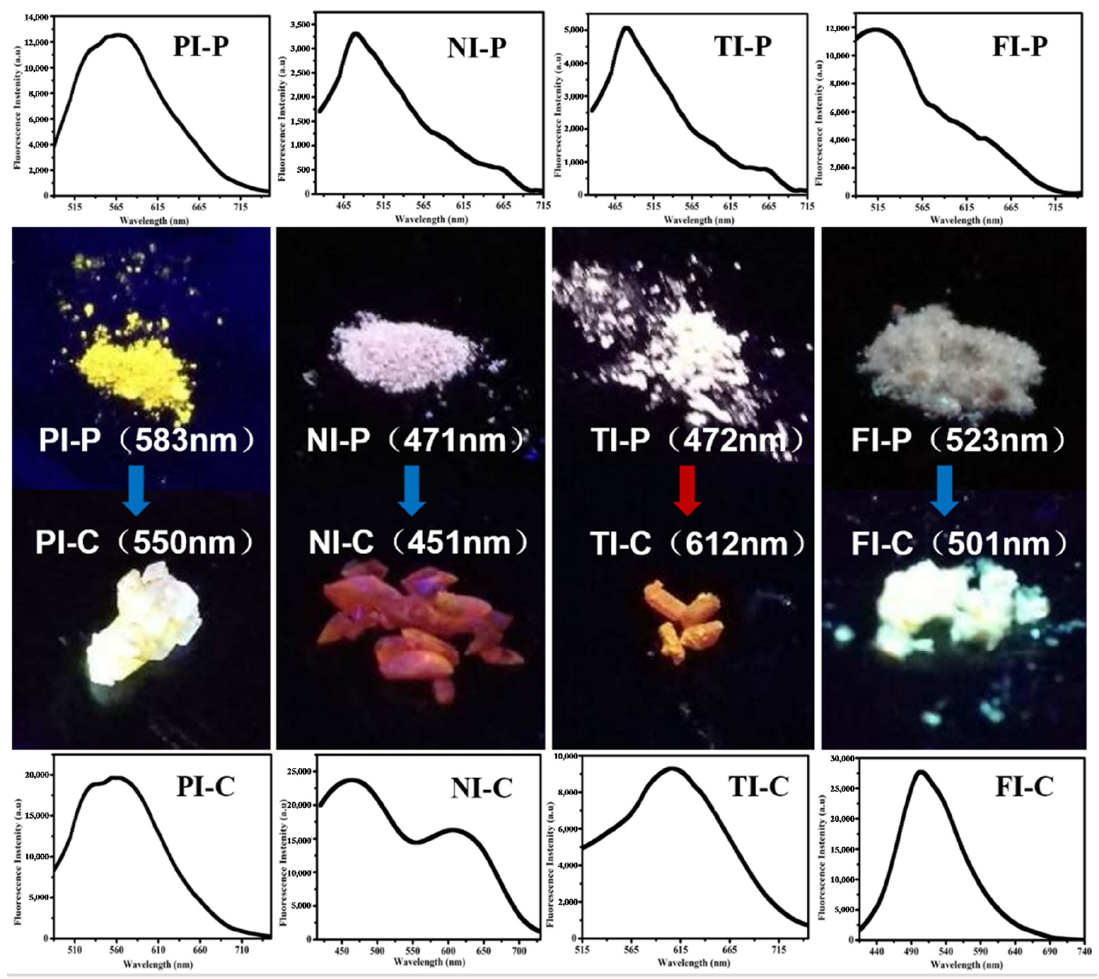
Figure 3. Photo images and PL spectra of the crystals and precipitation samples for PI , NI , TI, and FI , respectively ( λ ex = 365 nm).